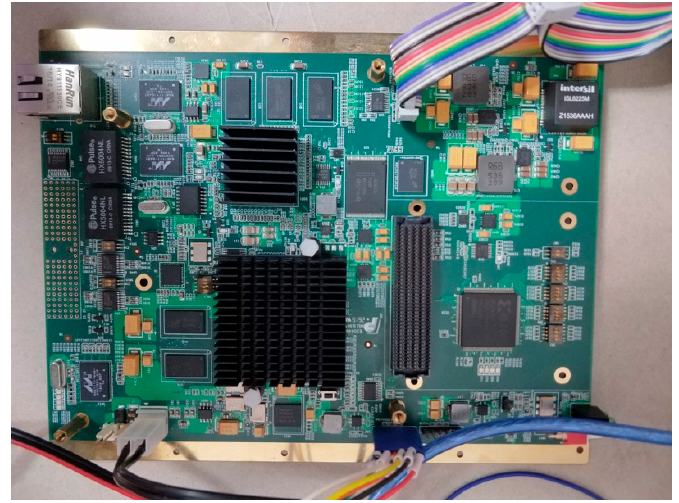
Figure 13. Photograph of the FPGA platform.